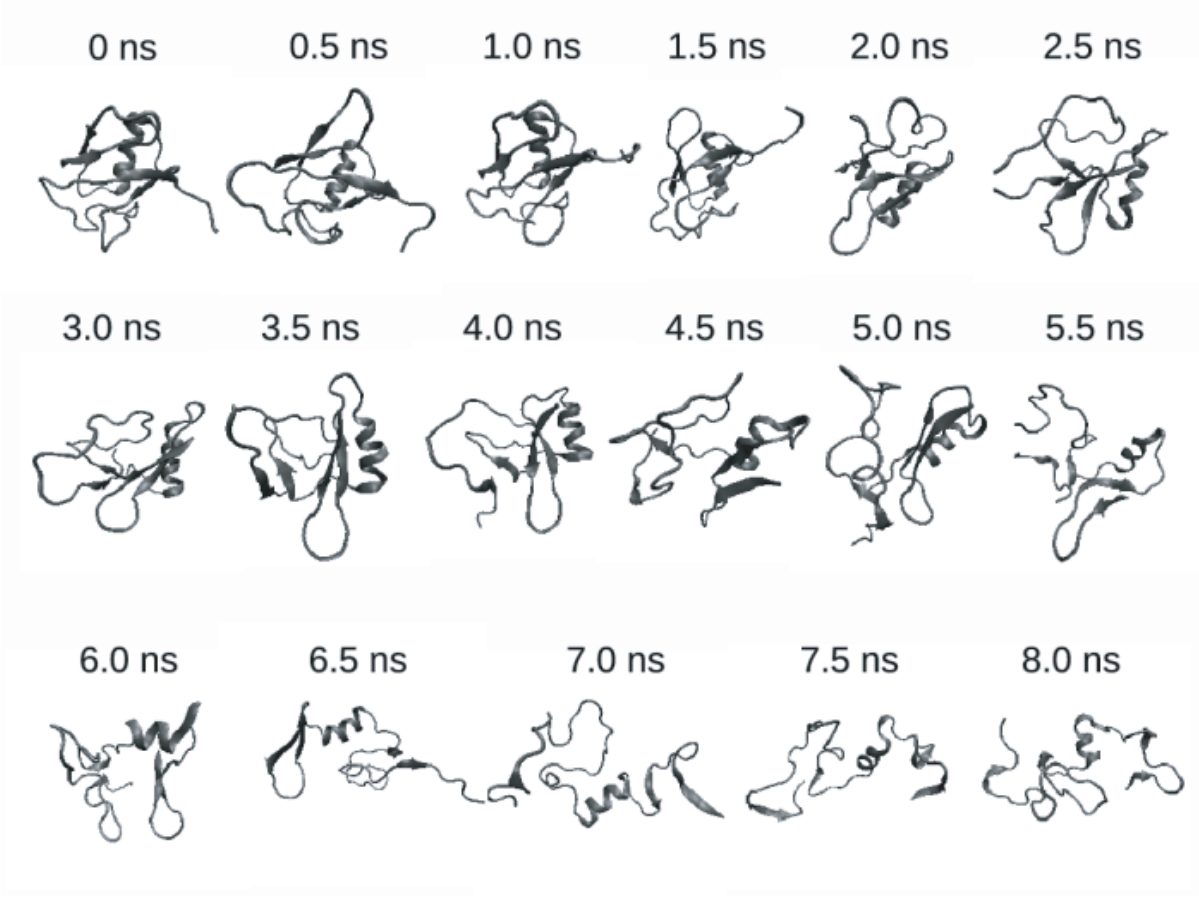
Figure 2. Snapshots of the structure of 1UBQ during unfolding. 500 ps (0.5 ns) snapshots are shown here.